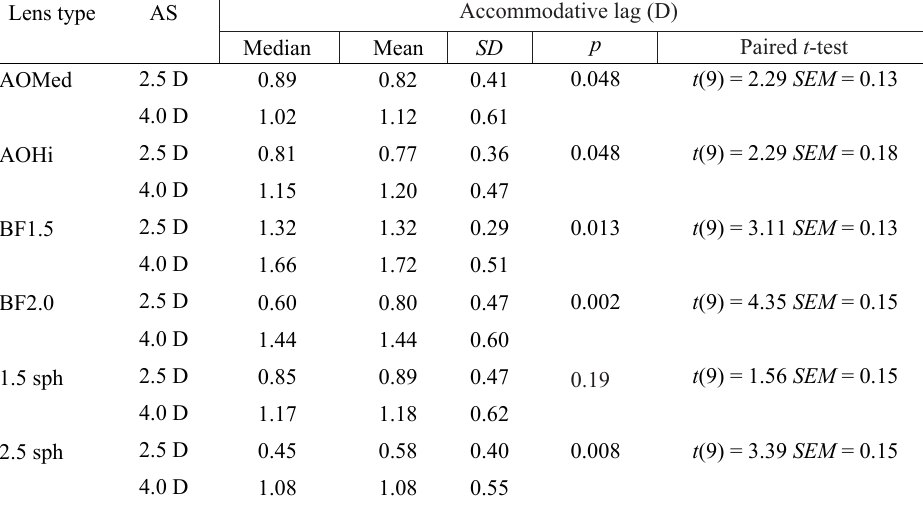
Table 2. Accommodative lag median and mean values with standard deviation ( SD ) in diopters for contact lenses of different types and power profiles, as well as dependent samples’ t -test p -values at 40 cm and 25 cm